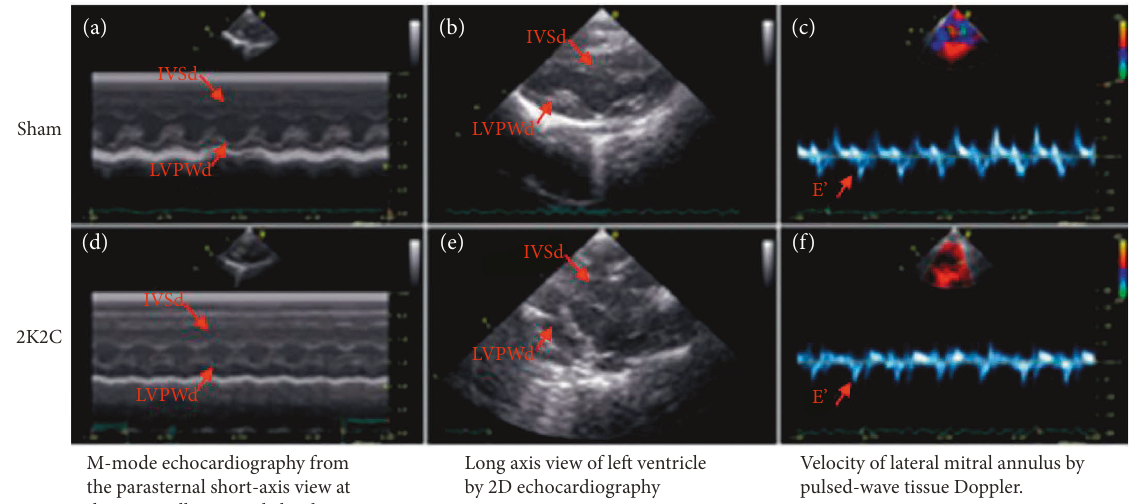
M-mode echocardiography from the parasternal short-axis view at the LV papillary muscle level Figure 2: The imaging of echocardiography of the two groups. The diameter of interventricular septum and posterior wall at end-diastole (IVSd, LVPWd) were thicker in 2K2C group (d, e) than the sham group (a, b). The Velocity of mitral annulus at the early diastole (e’) was lower than in 2K2C group (f) than the sham group